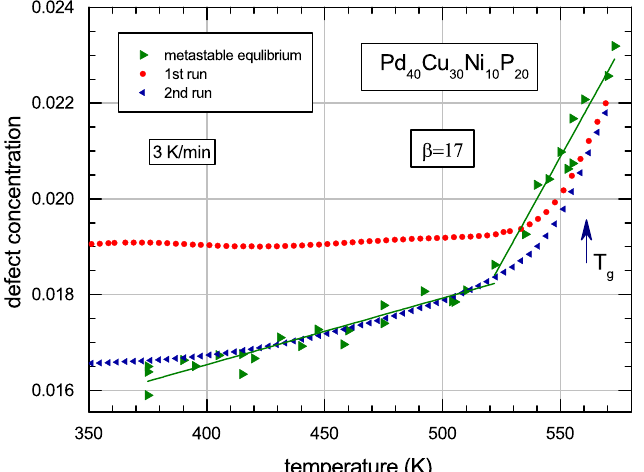
Figure 6. Temperature dependences of the interstitialcy defect concentration for bulk Cu Ni P glassy P d in the initial (first run) and relaxed (second run) states measured 40 30 10 20 at 3 K/min together with the metastable equilibrium defect concentration determined from prolonged isothermal shear modulus measurements. The arrow gives the calorimetric glass transition temperature